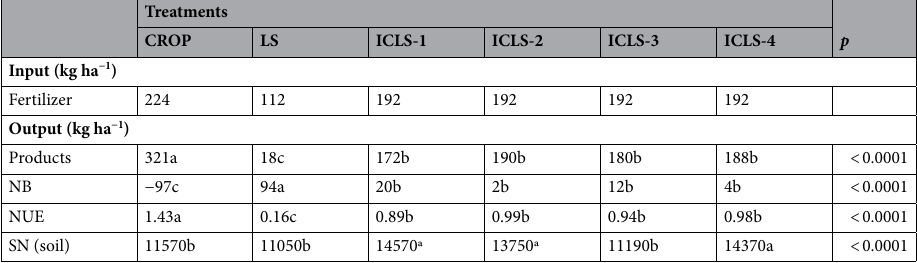
Table 1. Estimate of the nutrient balance (NB) and nutrient use efficiency (NUE), kg ha −1 , in two experimental years. Means followed by distinct letters are statistically different, according to the Tukey’s test at a 5% probability level. CROP production of maize grain, LS production of beef cattle in pasture, ICLS-1 maize and Marandu grass sowed simultaneously without herbicide, ICLS-2 maize and Marandu grass sowed simultaneously with herbicide, ICLS-3 delayed sowing of maize and Marandu grass, ICLS-4 maize and Marandu grass sowed simultaneously in maize lines and interlines with herbicide, SN soil nitrogen